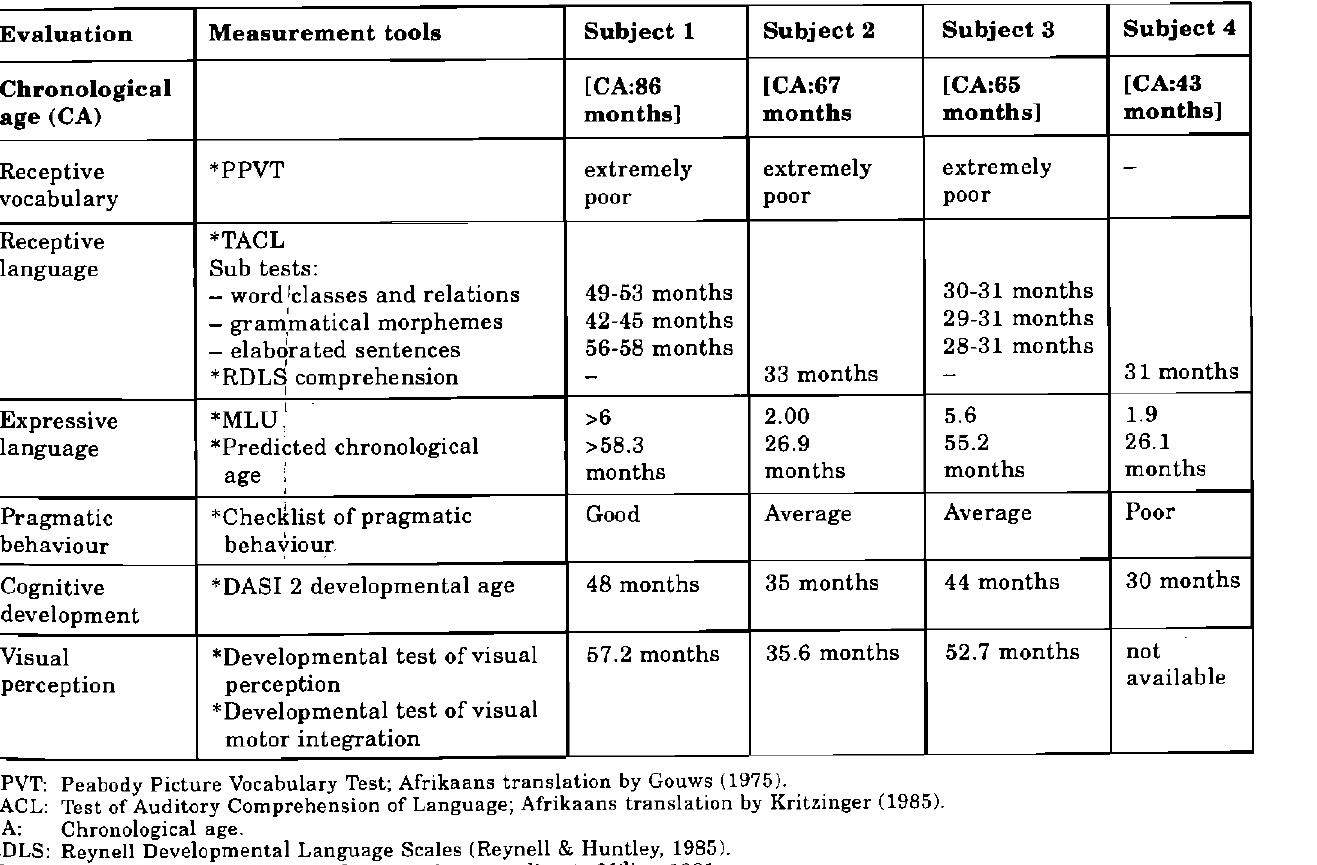
Table 2. Communication and visual perceptual abilities of the children